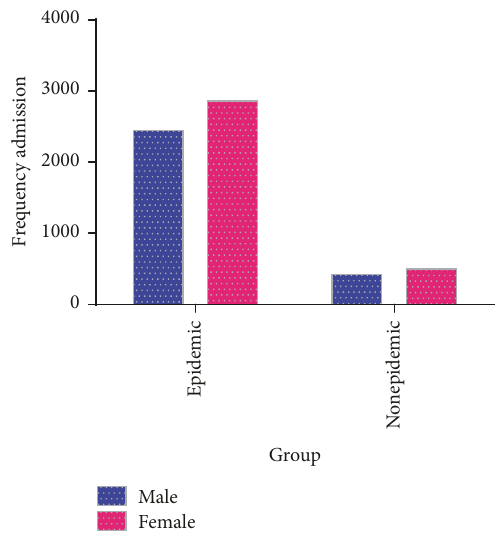
Figure 3: Frequency distribution of number of admissions during the epidemic and nonepidemic periods according to gender.